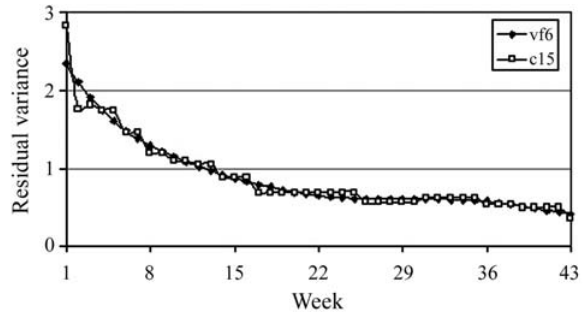
Figure 1 - Residual variances estimated by variance function (vf6) or step function